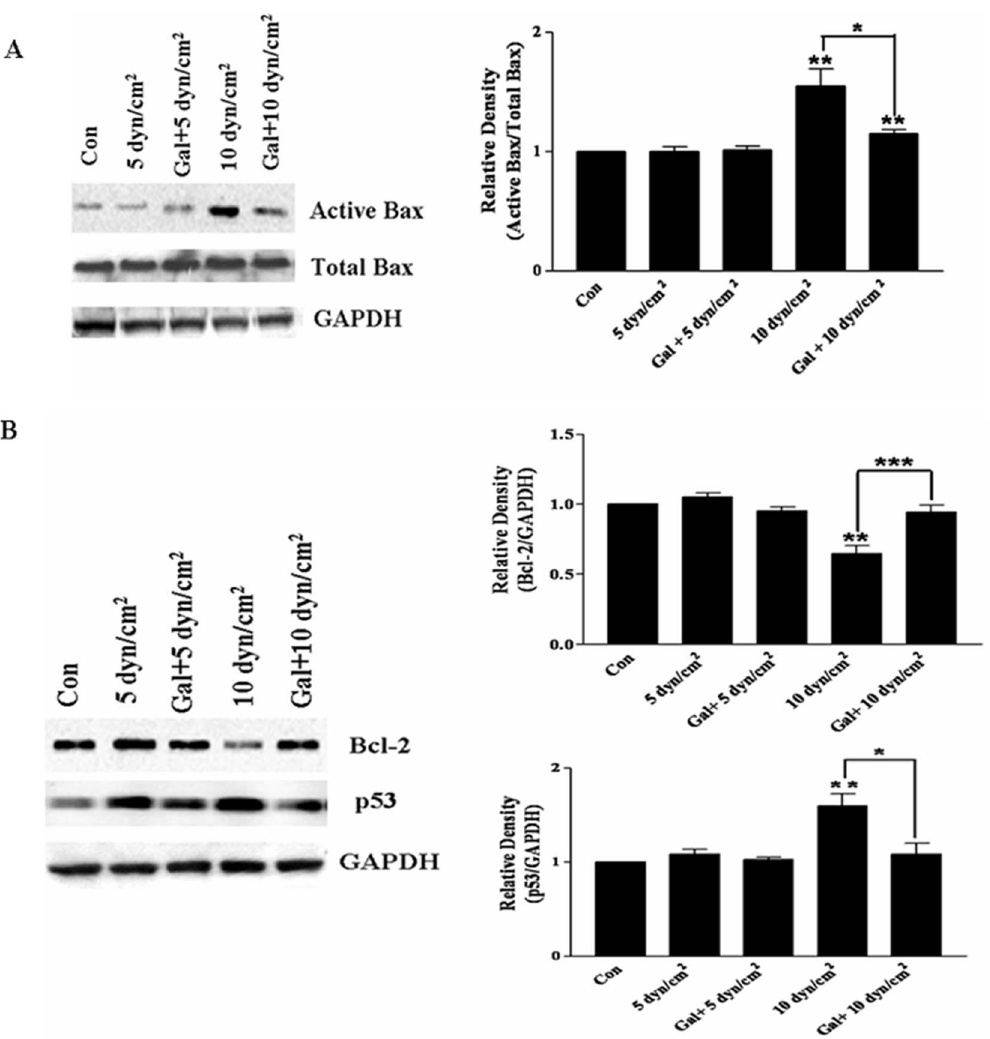
Figure 7. Effect of galanin on the cell apoptosis in the primary cortical neurons. A) The effect of galanin on Bax in cortical neurons after shear stress was assessed by immunoprecipitation assay. There was no significant decrease in Bax after shear stress of 5 dyn/cm 2 , but there was a significant increase in active Bax after shear stress of 10 dyn/cm 2 ; galanin inhibits the increase of active Bax. B) The expression of Bcl-2 and p53 were tested by galanin treatment. Shear stress of 10 dyn/cm 2 for 12 h decreased Bcl-2 and increased p53 expression, while galanin may inhibit the effect of shear stress. There were no significant changes in p53 and Bcl-2 after shear stress of 5 dyn/cm 2 for 12 h. * p , 0.05, ** p , 0.01 and *** p , 0.001 were considered to be statistically